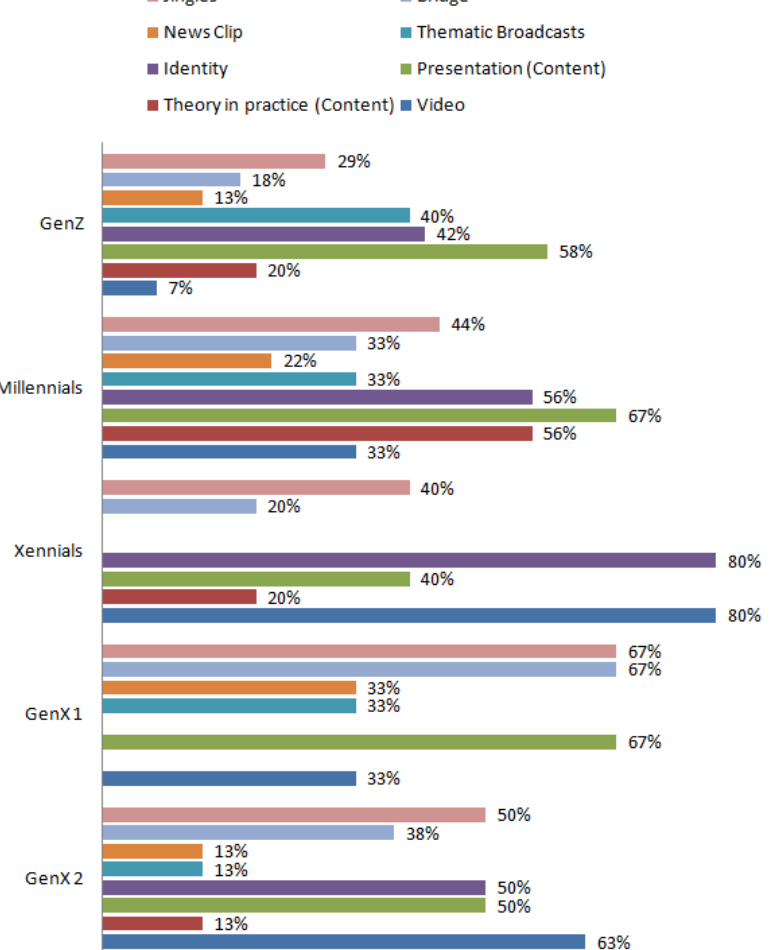
Figure 5. Grouped and adjusted qualitative data as quantitative data from the second part of the evaluation form based in age groups (genealogical cohorts).